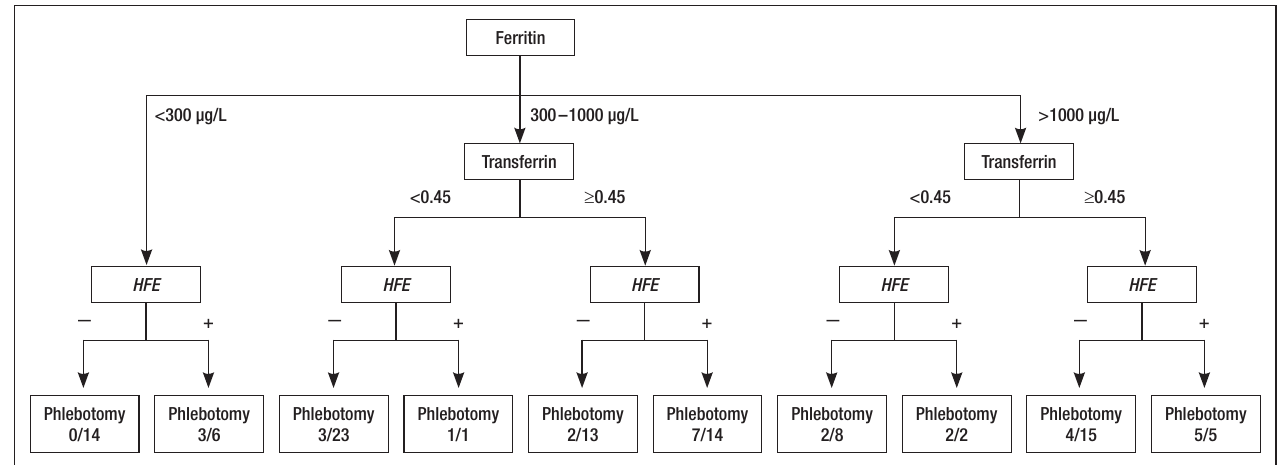
Figure 1) Decision-tree analysis. HFE Hemochromatosis gene